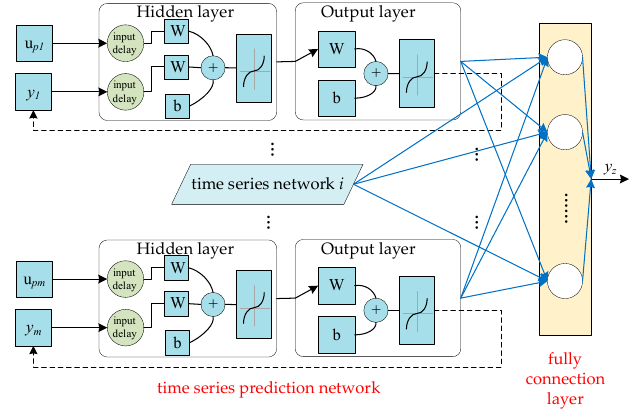
Figure 2. Structure of fusion network for “Circumjacent Monitoring-Blind Area Inference”.